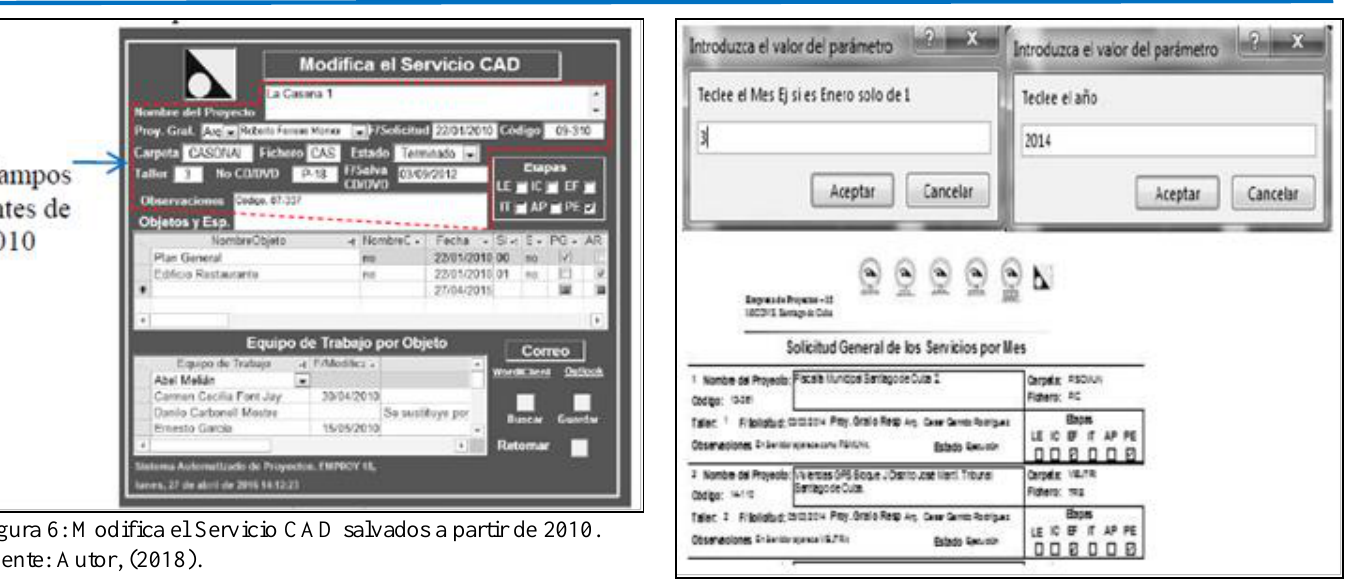
Figura 8: Ejemplo de un Informe. Fuente: Autor, (2018).